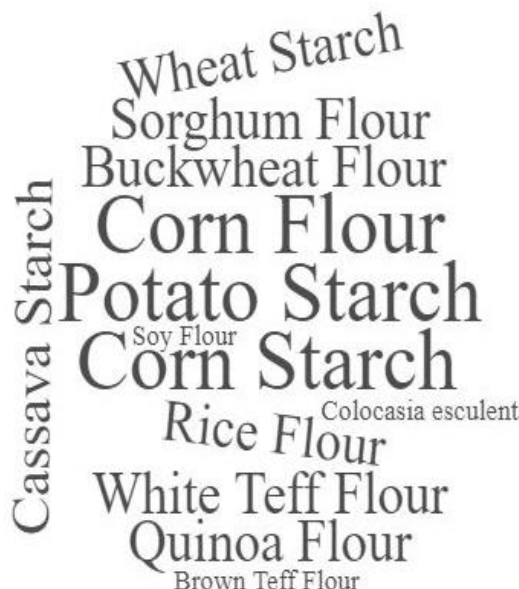
Figure 3. Word Cloud generated from GFB starch sources frequency.